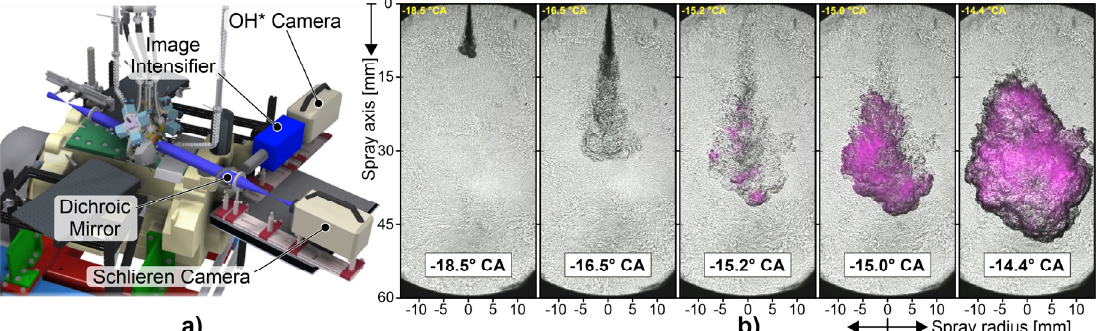
Figure 18. Optical setup at the Flex OeCoS for dual-fuel investigations by means of simultaneous Schlieren/OH* chemiluminescence ( a ); and an exemplary high-speed recording sequence of overlaid Schlieren and (colorized) OH* chemiluminescence ( b ). Operating conditions: methane/air charge λ = 2, engine speed 600 rpm, pressure/temperature conditions of 70 bar/760 K at (hydraulic) start of injection of –20° CA (dodecane pilot fuel, single hole nozzle Ø90 µm, p inj = 1000 bar) with an energizing time of 525 µs.